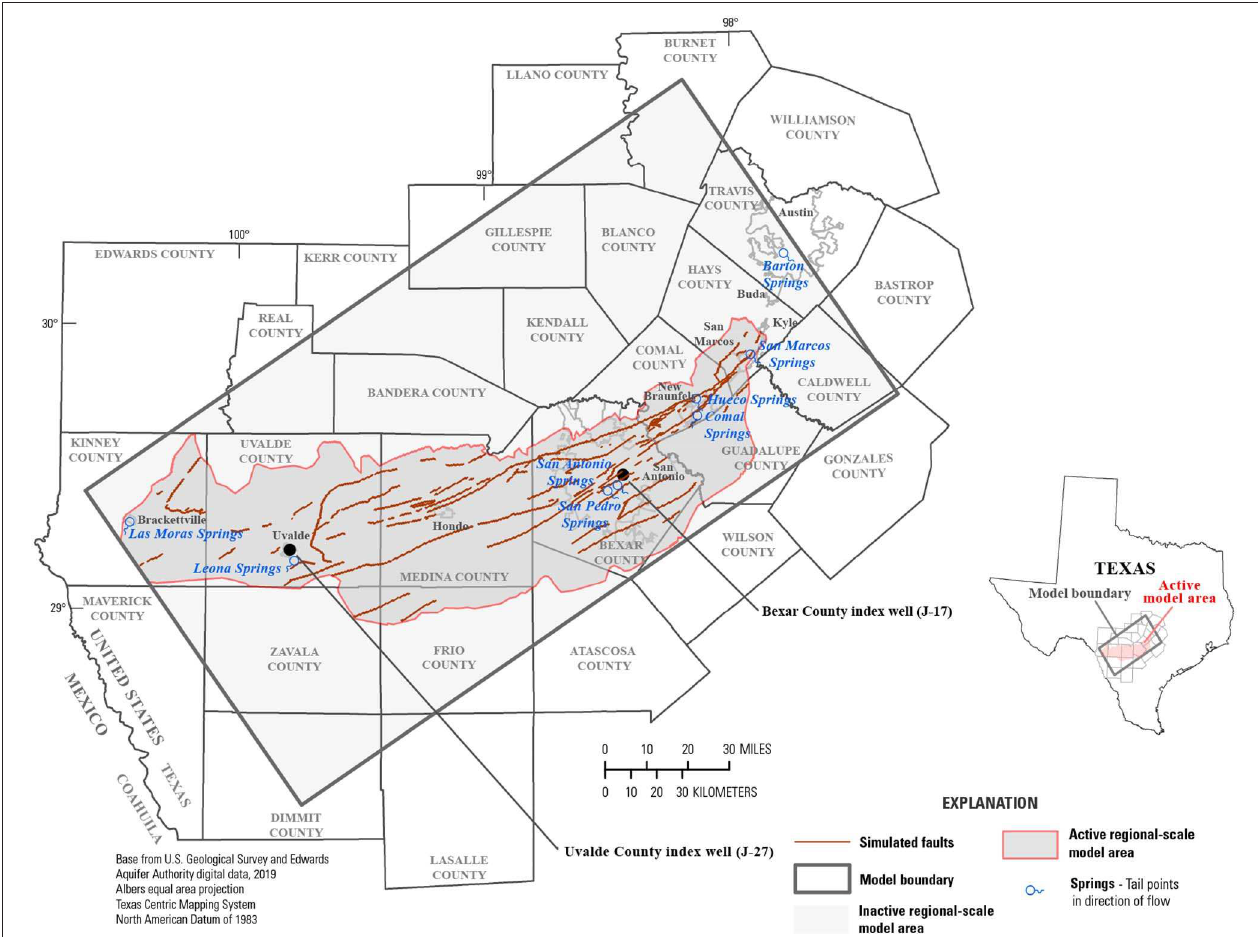
FIGURE 1 | The geographic extent of the active model domain (gray) and locations of springs and groundwater-level observation locations of primary interest to groundwater resource managers. Modified from Brakefield et al.